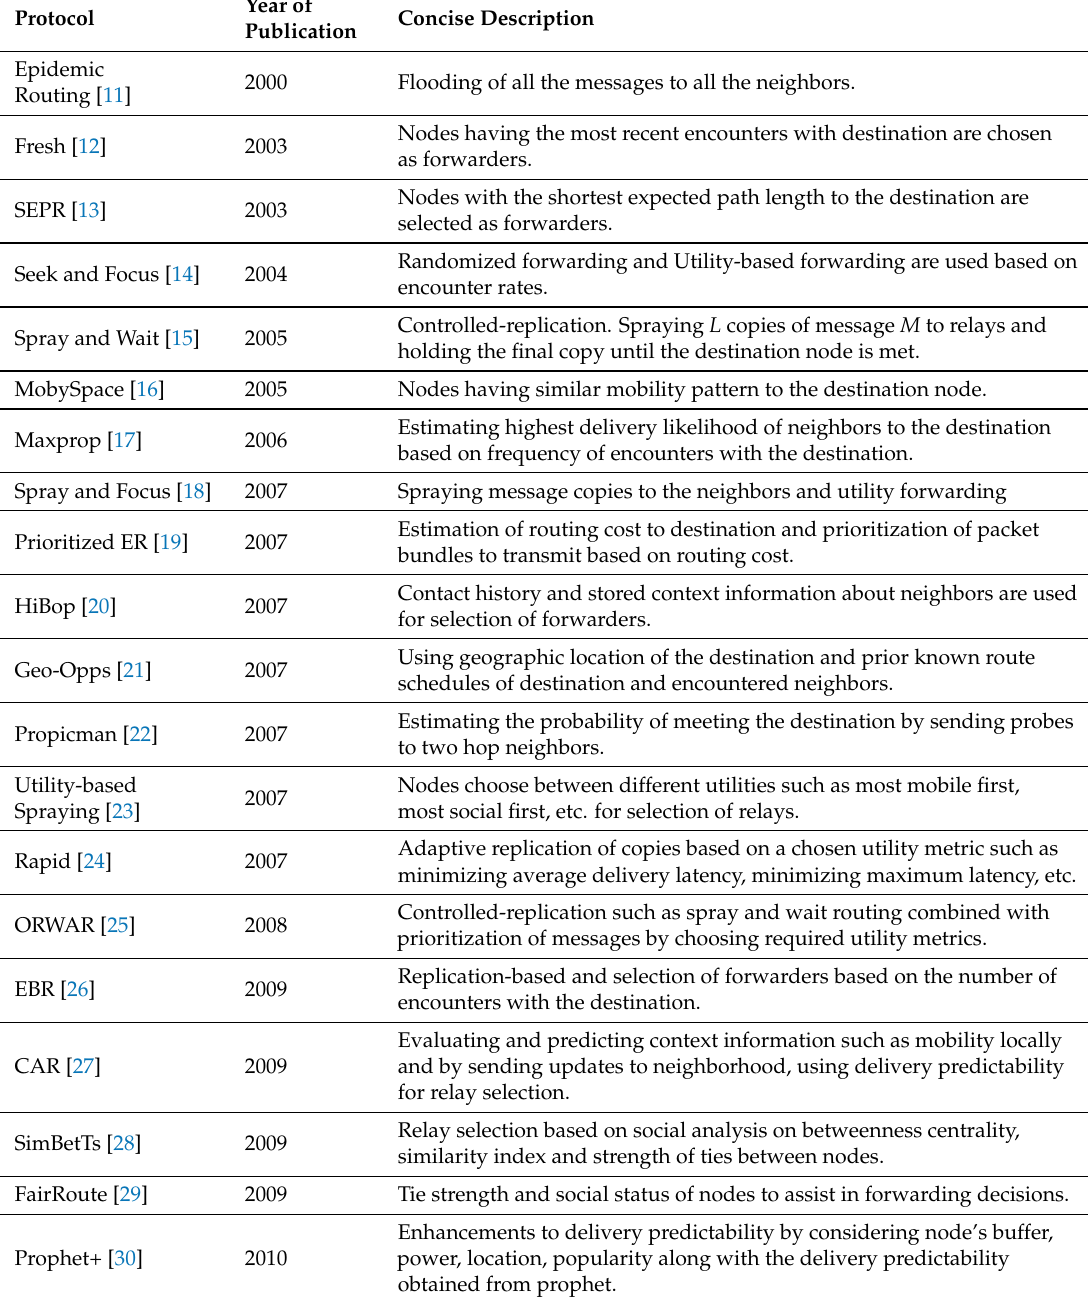
Table 1. OppNet protocols involved in this